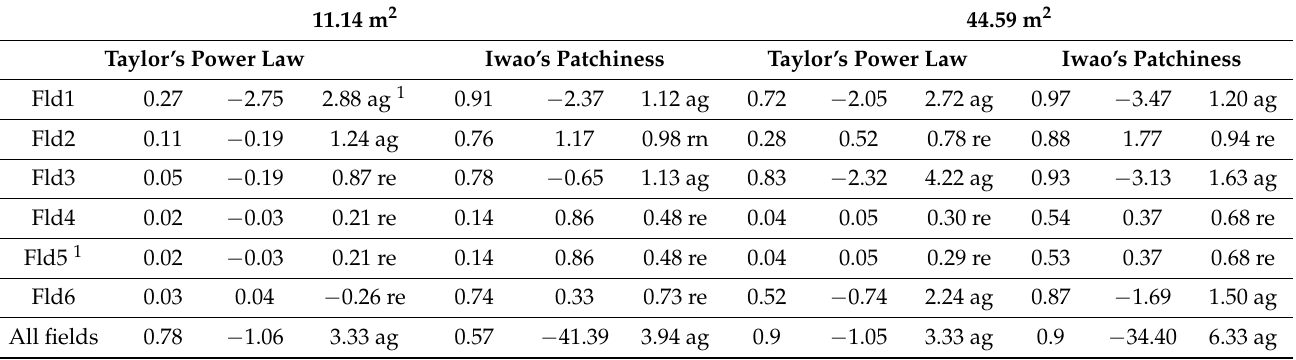
Table 3. Distribution pattern of Asian bean thrips males in small and large bean plots using flower